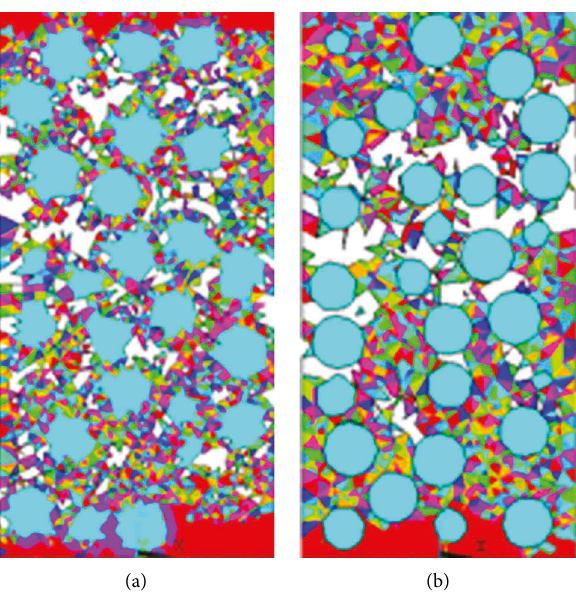
Figure 5: Different damaged sections of the model. (a) Model of random aggregate. (b) Interface model of random